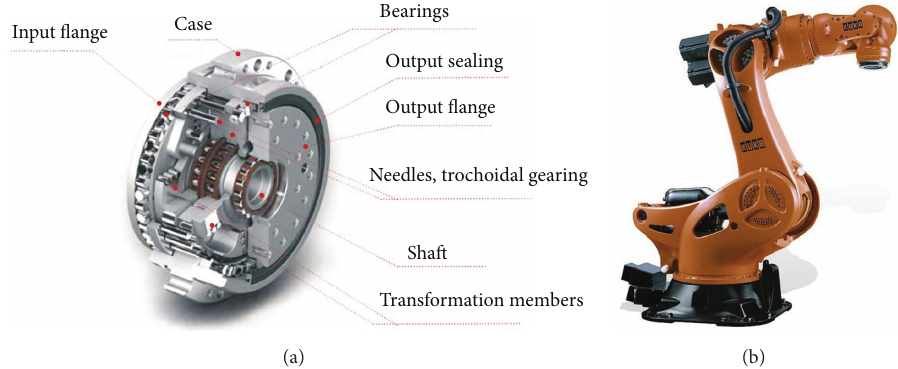
Figure 2: Diagnosed cycloid gearbox (a) applied in the joints of a robotic manipulator